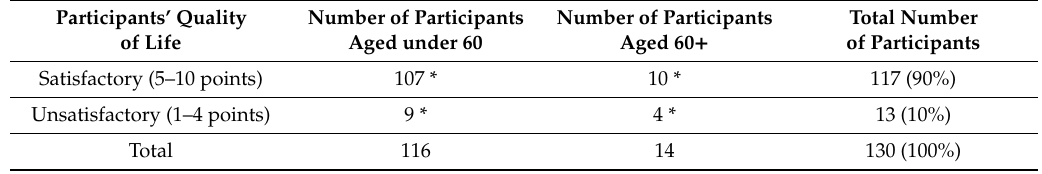
Table 5. Satisfactory and unsatisfactory quality of life (self-reported) by